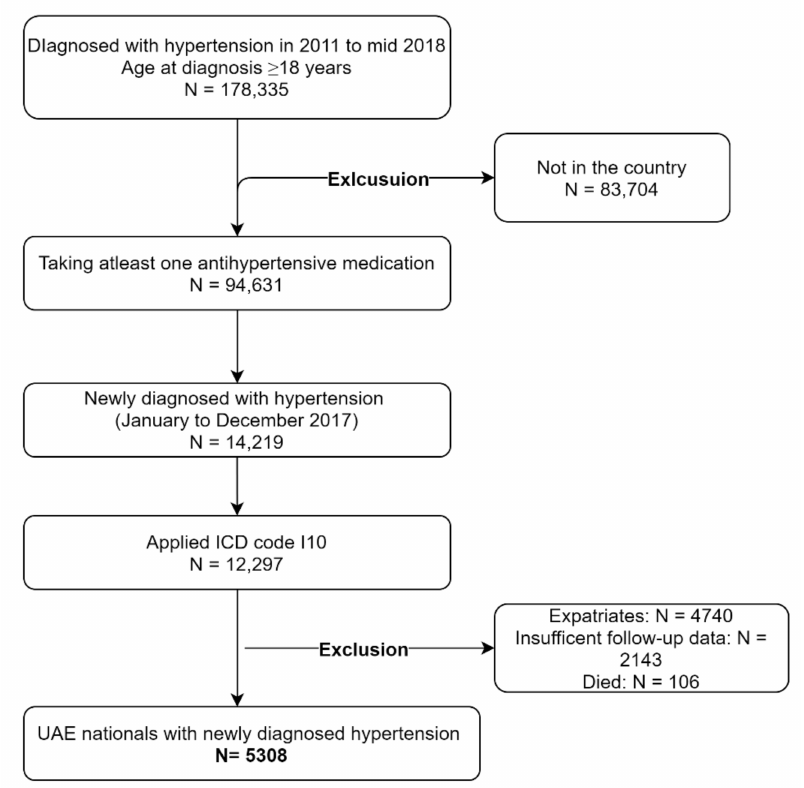
Figure 1. Consort flow diagram of the cohort